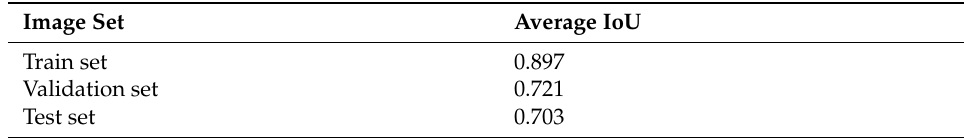
Figure 20. Ilustrative figure to explain the IoU metric. Table 10. IoU for each set of images.